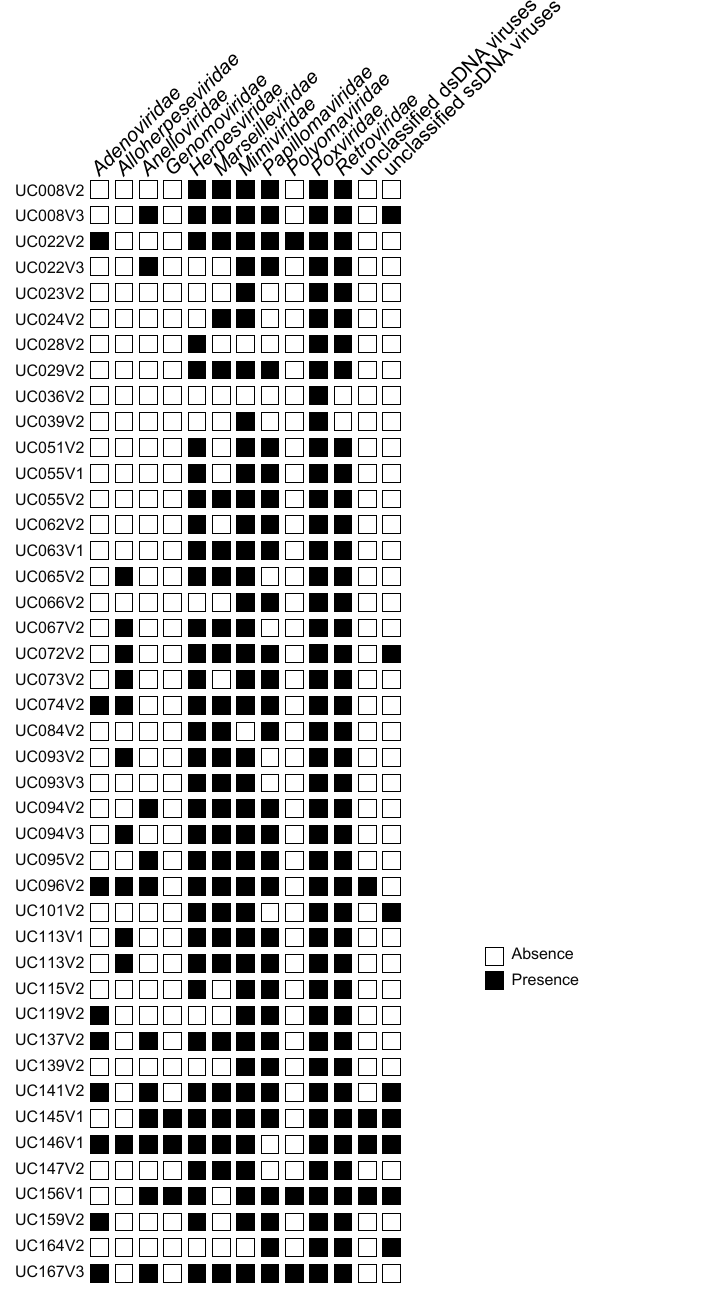
Figure 1. Eukaryotic DNA viruses in South African adolescents. Presence (black square) and absence (white square) of eukaryote-infecting families of DNA viruses identified by viral metagenome sequencing after rolling-circle-amplification of viral-nucleic acids extracted from vaginal samples from 33 South African women based on BLASTx analysis of contigs >500 bp against the NCBI viral Refseq database. PID and study visit at which samples were collected (V1 = baseline, V2 = 4 months, V3 = 8 months) are shown. This analysis includes samples from the 33 women included in the viral metagenome sequencing